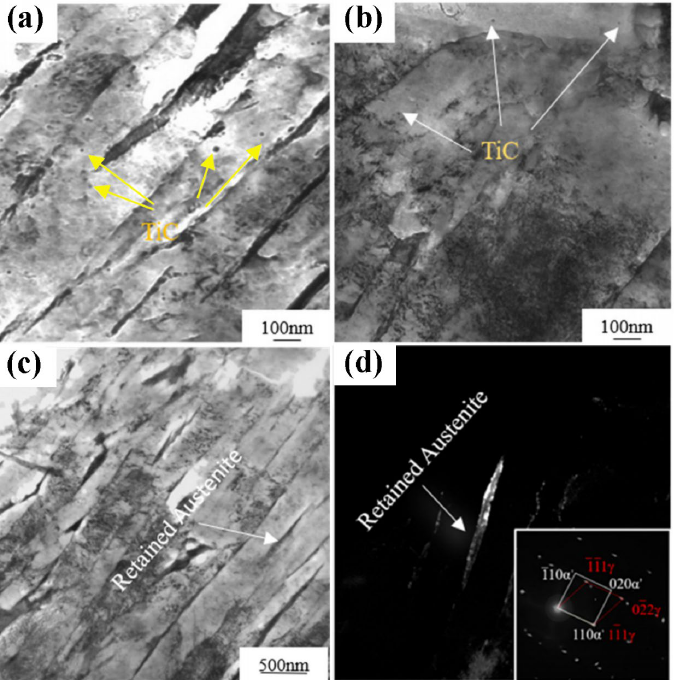
Figure 3. TEM analysis of martensitic UHSS [36]. ( a , b ) Lath martensite and nano-scale TiC carbides precipitated. ( c , d ) Retained austenite between lath martensites. Reprinted with permission from [36]. Copyright 2022 MDPI.